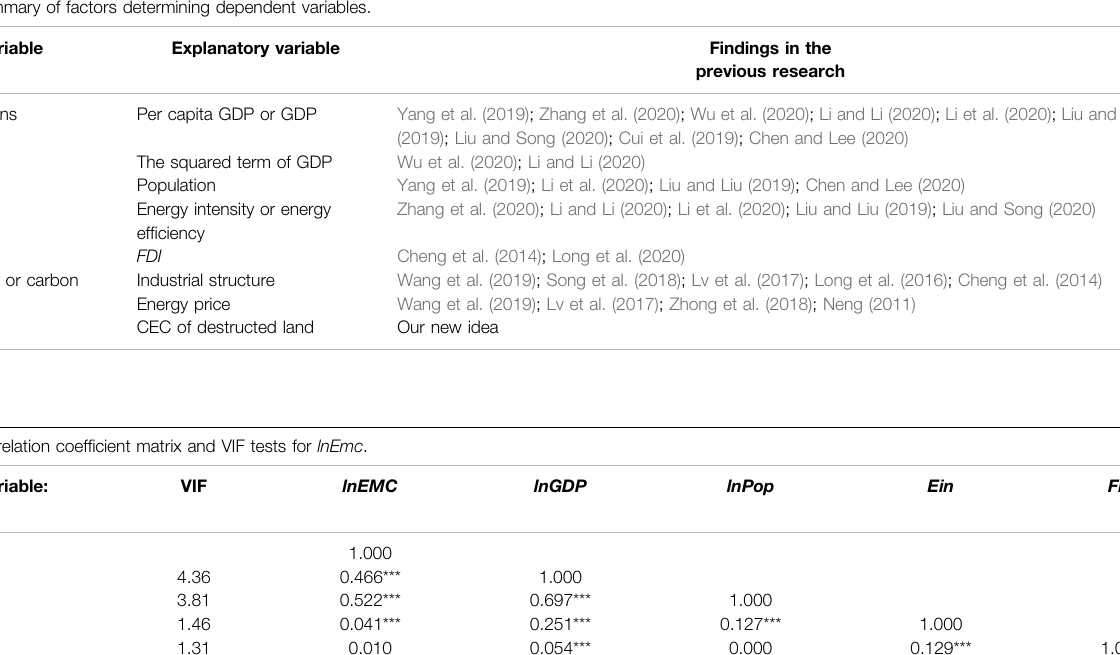
TABLE 2 | Summary of factors determining dependent variables.